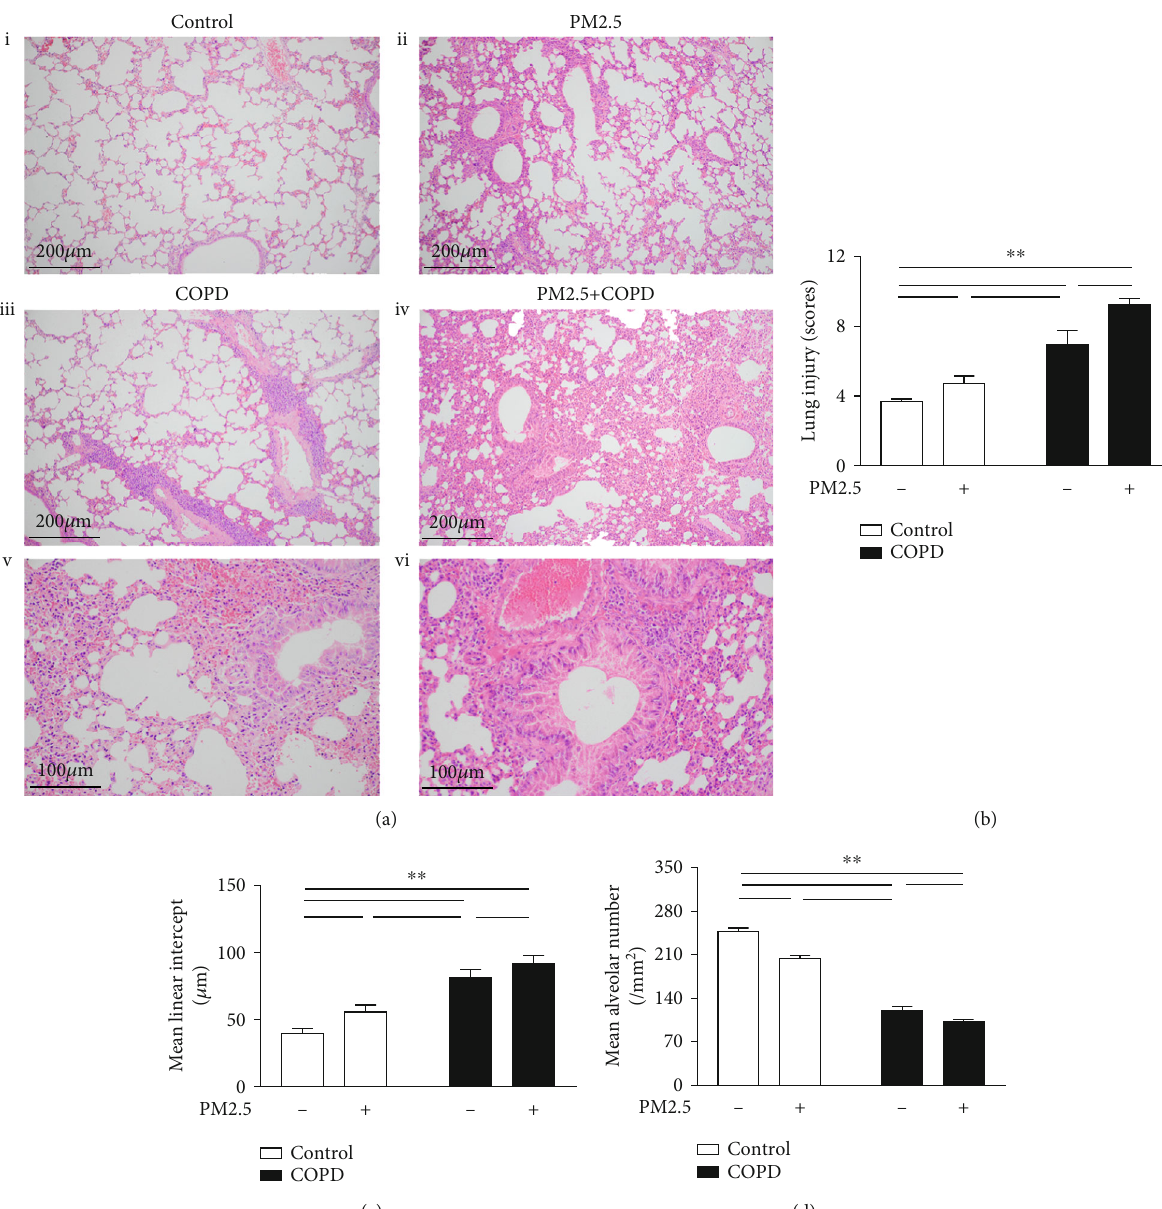
Figure 2: The e ff ect of PM2.5 on lung histological injury in rats with COPD. (a) Lung tissue HE staining of di ff erent groups of rats. (i) Control, an intact structure of pulmonary alveoli and airway (magni fi cation, × 100); (ii) PM2.5, mild in fi ltration of in fl ammatory cells and thickening of airway wall (magni fi cation, × 100); (iii) COPD, alveolar cavity enlargement and vascular wall thickening (magni fi cation, × 100); (iv) PM2.5+COPD, chronic obstructive bronchiolitis with thickening of the airway wall and in fi ltration with in fl ammatory cells (magni fi cation, × 100); (v) COPD, airway wall thickening and in fl ammatory cell in fi ltration (magni fi cation, × 200); (vi) PM2.5+COPD, increased thickening of airway wall and in fi ltration of in fl ammatory cells compared to COPD (magni fi cation, × 200). (b – d) Quantitative analysis of lung injury, that is, the level of (b) LIS, (c) MLI, and (d) MAN of the lungs in each group. LIS: lung injury scores; MLI: mean linear intercept; MAN: mean alveolar number. The data are expressed as the means ± SD ( n = 6~7 ). ∗∗ p < 0 : 01 , ∗ p < 0 : 05